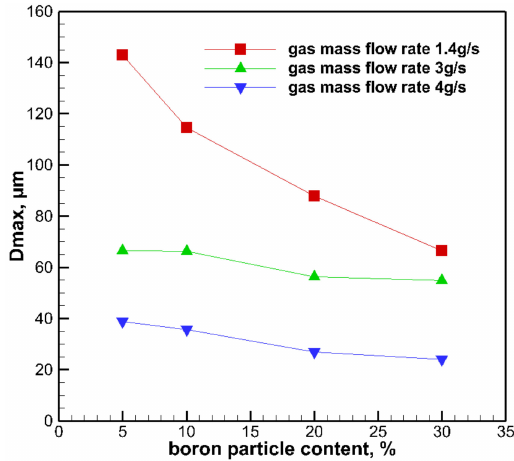
Figure 10. D max vs. boron particle content.